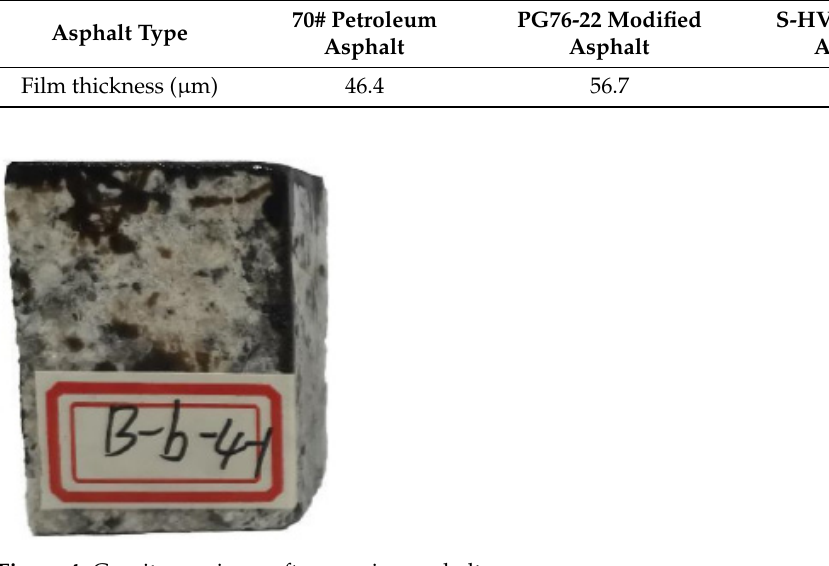
Figure 4. Granite specimen after pouring asphalt.